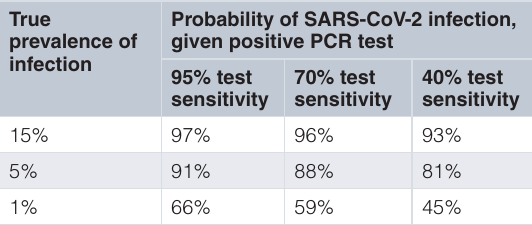
Table 2. Estimated probability of SARS-CoV-2 infection given a positive PCR under various assumptions about the true prevalence of infection and the sensitivity of the test 24 . All estimates assume a test specificity of